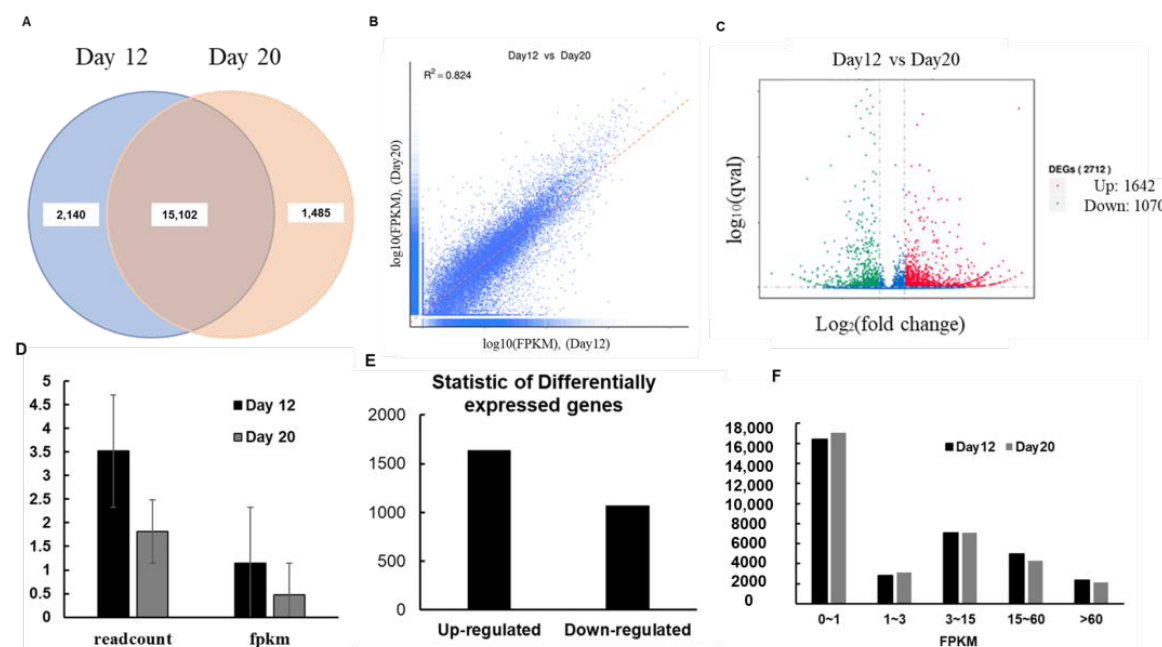
Figure 1. Analysis of genes differentially expressed between 12- and 20-d-old Arabidopsis seedlings. ( A ) Venn diagram of differentially expressed genes (DEGs). The sum of the numbers in each circle represents the total number of genes expressed within a sample, and the overlap represents genes expressed in both samples. ( B ) Correlation analysis of gene expression between samples. R 2 indicates the square of the Pearson’s correlation coefficient. ( C ) Volcano plot of DEGs. The x -axis shows the fold change in gene expression between different samples and the y -axis shows the statistical significance of the differences in gene expression. Significantly up- and downregulated genes are highlighted in red and green, respectively. Genes showing no differential expression between 12- and 20-d-old seedlings are shown in blue. Comparison of the expression levels of DEGs ( D – F ). Comparison of, read count, and FPKM values of DEGs ( D ) between 12- and 20-d-old seedlings. ( E ) Summary of DEGs. ( F ) FPKM statistic.